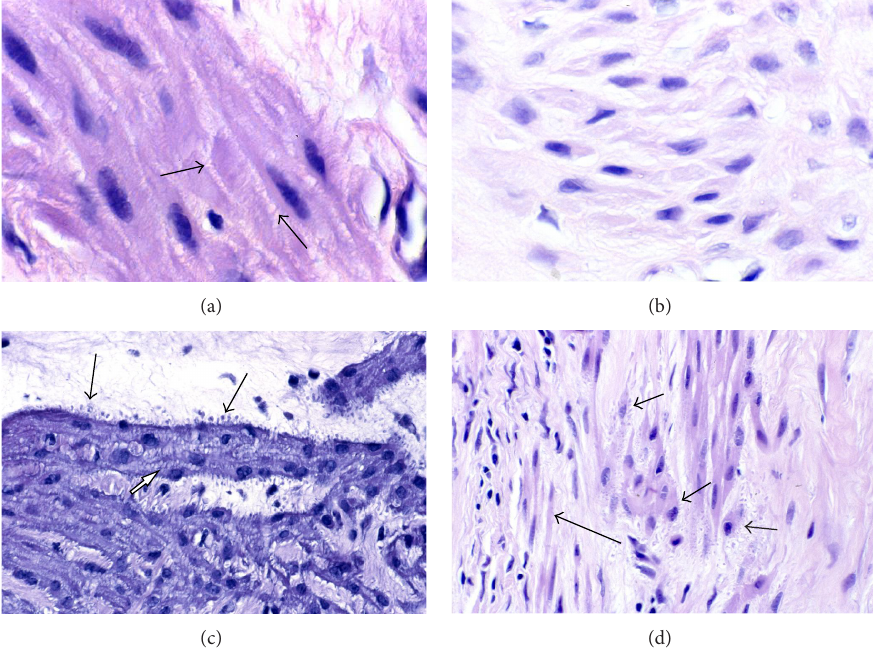
Figure 5: Phenotypic transformation: loss of lateral bars. Lateral bars (arrows) connecting myometrial smooth muscle cells in (a) are believed torepresentsitesofgapjunctionattachmentsbetweenadjacentcellsforpurposesofcoordinatedcontraction.Theselateralbars,orintercellular attachments, are not seen between the fibroid tumor cells in (b). We believe that this is another indication of the phenotypic transformation to non-contractile cells. In (c), many of the fibroid myocytes exhibit lateral buds (long arrows), imparting a knobby appearance to the free borders of the cells. It is thought that these buds may represent remnants of the lateral bars. Note that the cytoplasmic borders of contiguous myocytes within the fascicle, however, do not show these lateral buds, but rather show retention of lateral bars, or attachments (short arrow), as noted in the myometrium. In (d), there are a few myocytes displaying lateral buds, which have a more frayed or feathered appearance (short arrows). Note that in the fully transformed cells on the left (long arrow), there are neither lateral bars or lateral buds. Original magnification of (a) and (b): 330x, (c) and (d):